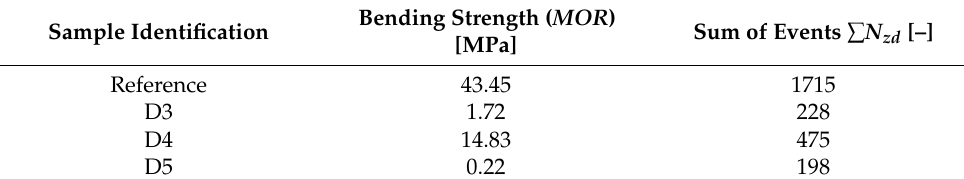
Table 1. Summary of averaged modulus of rupture ( MOR ) and example event sum ∑ N zd .